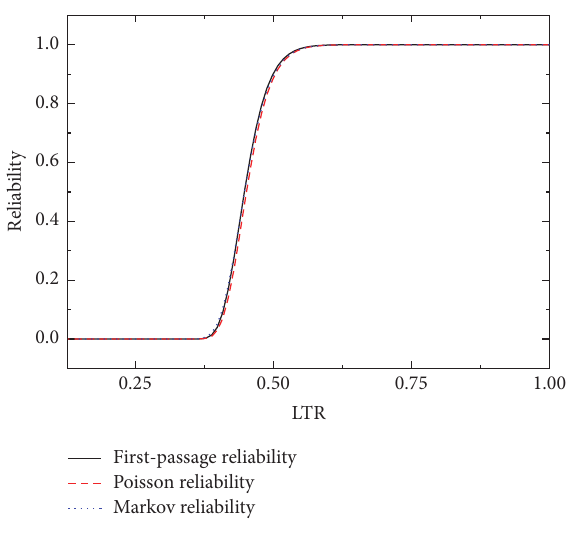
Figure 6: Reliability of LTR.